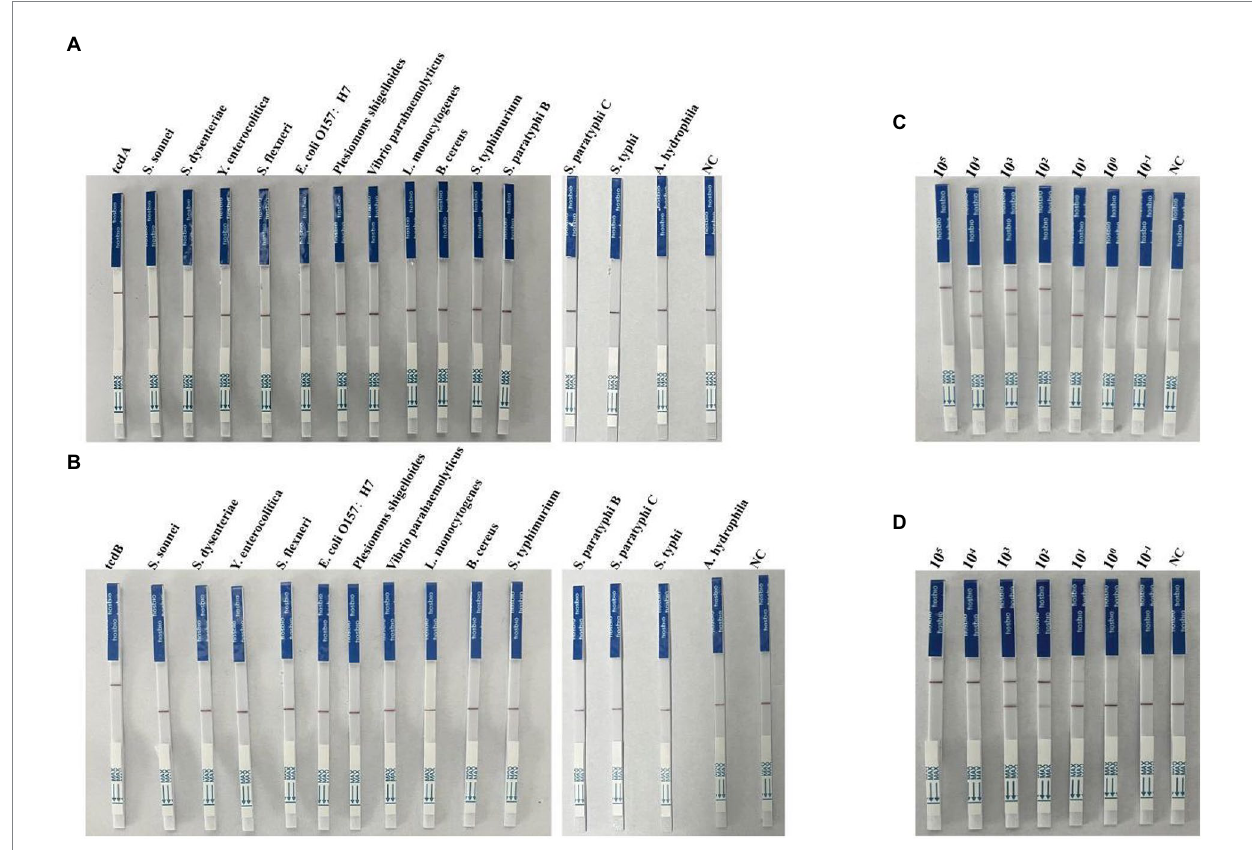
FIGURE 5 Determination of specificity and sensitivity of the multiplex RPA-Cas12a-LFS. (A,B) Specificity analysis of multiplex RPA-Cas12a-LFS. (C,D) Sensitivity analysis of multiplex RPA-Cas12a-LFS for tcdA gene (C) and tcdB gene (D) . NC, negative control. All experiments were repeated at least 3